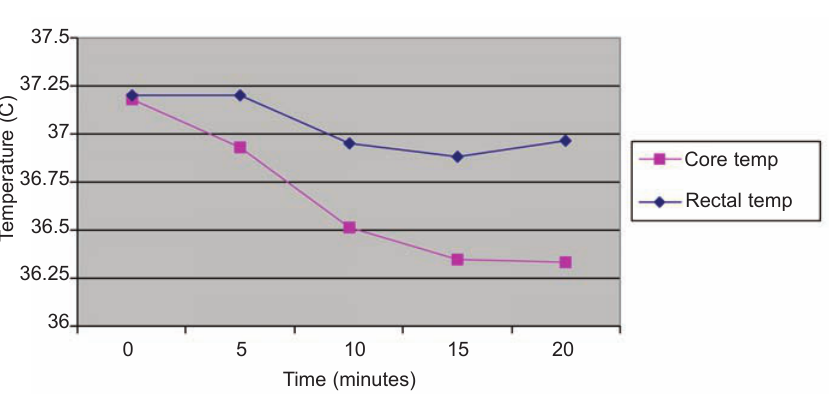
Figure 5. Core temperature (Swan-Ganz) vs. rectal temperature for head-cooled